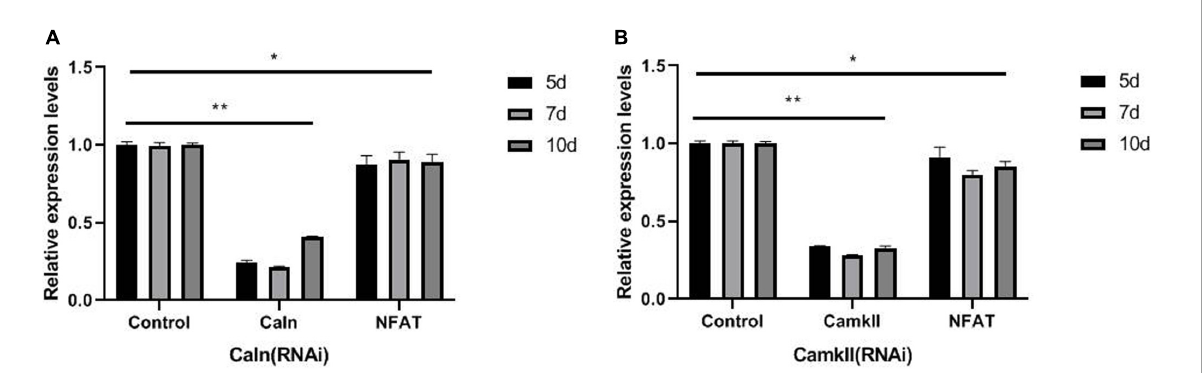
FIGURE3 DjNFAT mRNA levels in DjCaln (RNAi) and DjCamkII (RNAi) during planarian head regeneration. (A) DjNFAT mRNA levels in DjCaln (RNAi) planarians at 5, 7, and 10 days during planarian head regeneration, n = 4. (B) DjNFAT mRNA levels in DjCamkII (RNAi) planarians at 5, 7, and 10 days during planarian head regeneration, n = 4. * p < 0.05, ** p <